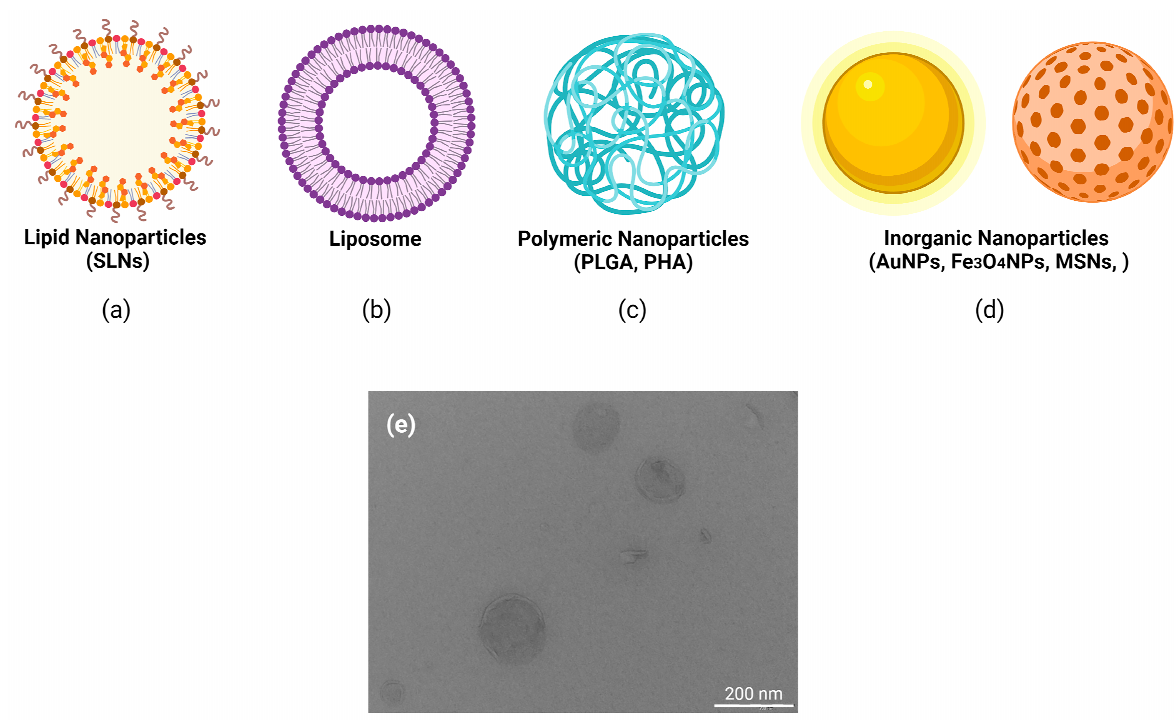
Figure 3. Main types of nanoparticles used in clinical trials for the delivery of nucleic acids. Different type of nanoparticle formulations designed for tissue targeting in order to achieve therapeutical effects. ( a ) lipid nanoparticles (e.g., solid lipid nanoparticles, SLNs), ( b ) liposomes, ( c ) polymeric nanoparticles (e.g., polylactide-coglycolide, PLGA; polyhydroxyalka- noates, PHAs) ( d ) inorganic nanoparticles (e.g., gold nanoparticles, AuNPs; iron nanoparticles, Fe 3 O 4 NPs; mesoporous silica nanoparticles, MSNs), ( e ) transmission electron microscopy (TEM) image of cholesteryl oleate SLNs, fabricated at the Faculty of Pharmacy and Food Science (Universitat de Barcelona), showing the scale bar in nm. Image created with BioRender.com.